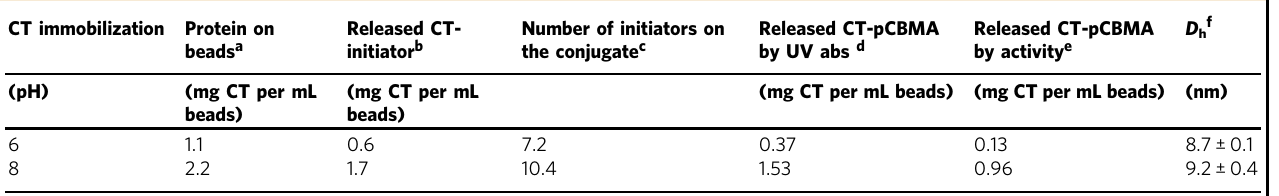
a Concentration of immobilized CT determined by a microBCA protein assay. The concentration of CT on the beads at pH 6.0 is less than pH 8.0 indicating more possible binding sites at pH 8.0 b Concentration of released CT-initiator determined by a microBCA protein assay c Average number of initiators per CT determined by fl uorescamine amine assays using standard protocols d Concentration of released conjugates estimated by UV absorption e Concentration of released conjugates estimated by enzyme activity using suc-AAPF-pNA as a substrate f Hydrodynamic diameter of the CT-pCBMA conjugates was measured using dynamic light scattering in 20mM sodium citrate (pH 3.0) at 25°C showing an increase in conjugate size over native CT ( D h = 4.4nm, number